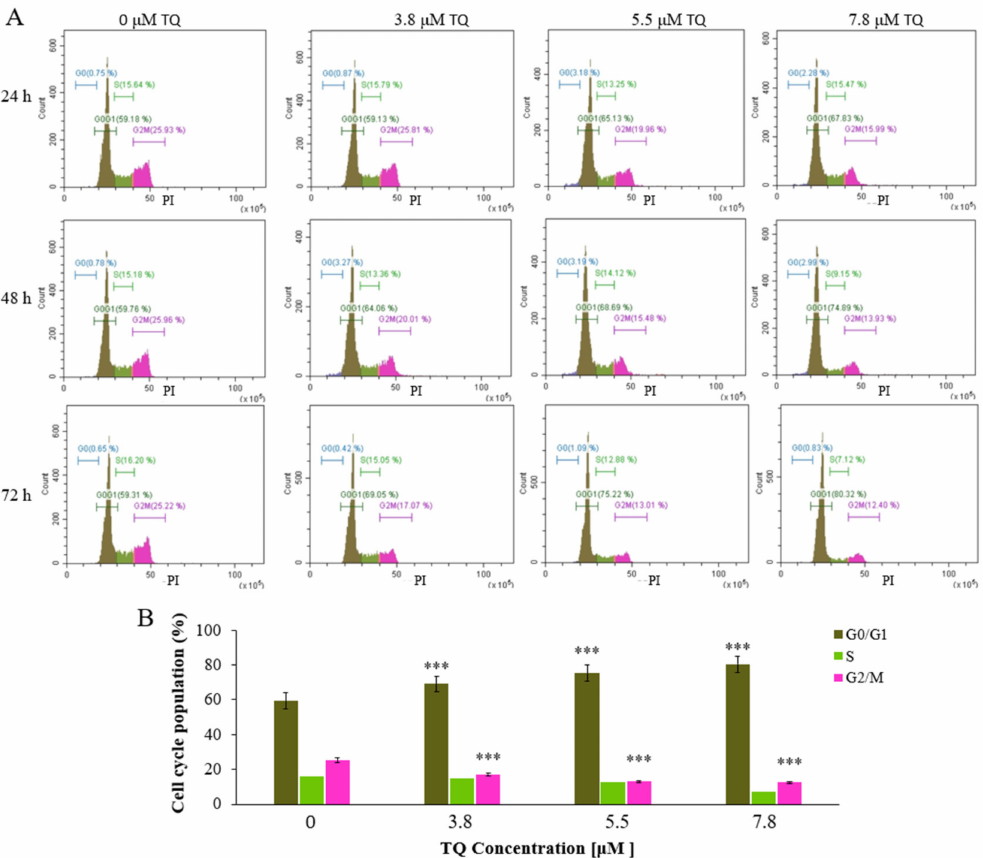
Figure 3. Flow cytometry histograms for cell cycle analysis of MV4-11cells. ( A ) Cells were treated with TQ (7.8 µ M, 5.5 µ M, and 3.8 µ M for 24 h, 48 h, and 72 h). Thymoquinone significantly increased the G0/G1 population in MV4-11 cells in a time- and dose-dependent manner. ( B ) The graph indicates the cell cycle distribution in MV4-11 cells after 72 h of exposure to IC 50 values. Data are representative of three independent experiments and expressed as mean ± SD. Where *** p < 0.001 is significant versus untreated control cells. The mean of the G0/G1 population at all treatment groups showed significant differences when tested with repeated measures ANOVA ( p <